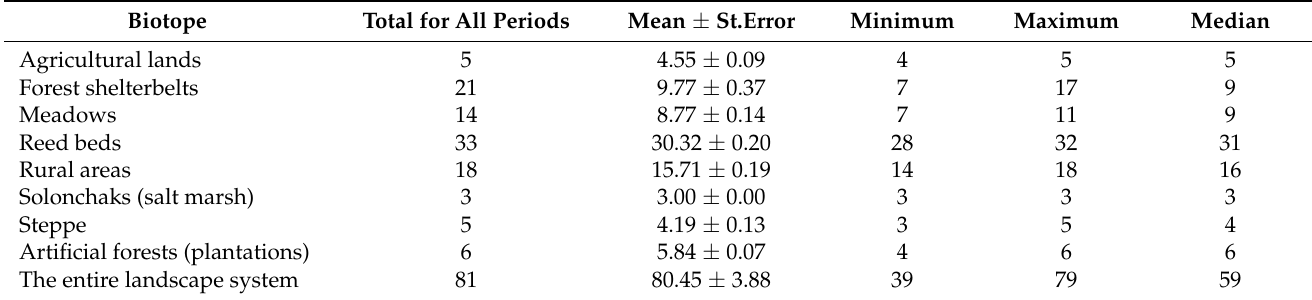
Table A3. Species richness of bird communities over the period (1988–2018, N =